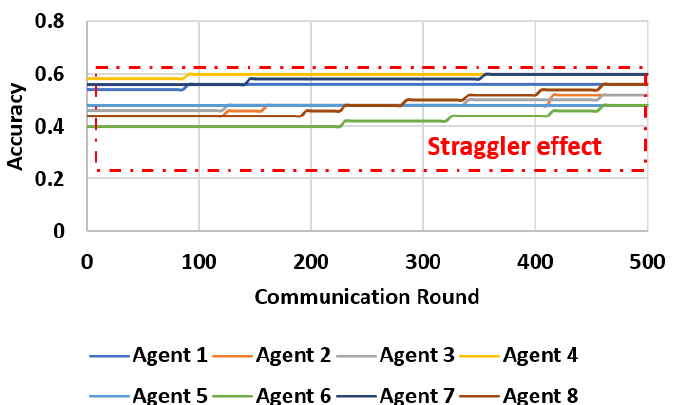
Figure 8. Straggler effects on participating FL agents’ (eight agents and six stragglers) model accuracy for the prediction of critical infrastructure